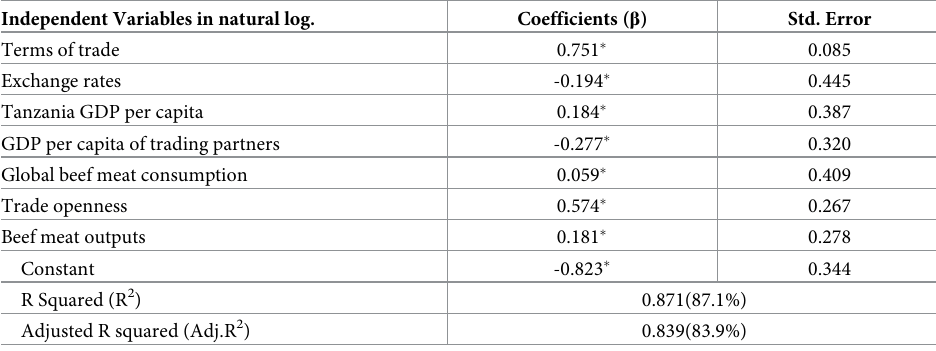
� Indicate significance level at 5% (P < 0.05). Dependent variable: Beef meat export quantity in